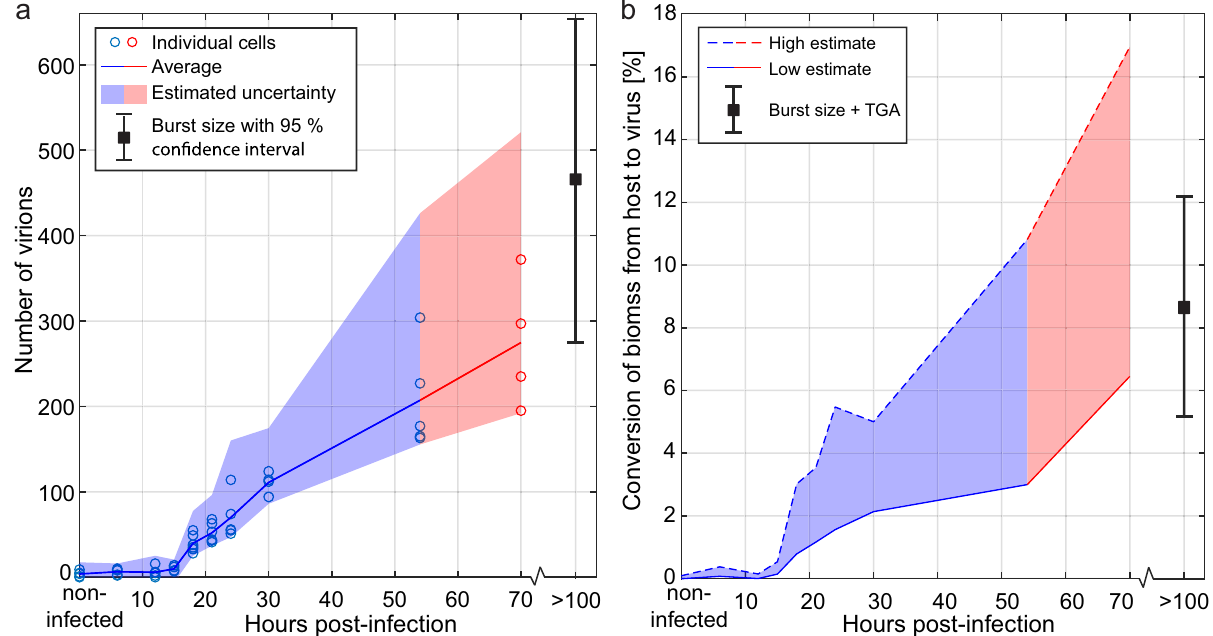
Figure 5. Virion production and conversion of biomass (C 1.3 + N 1.9 + O 0.1 ) as function of infection time. ( a ) The number of virions were counted in 52 different cells with infection times ranging from non-infected (0 h) to 70 h. The data at 70 hpi should be seen as a more approximate count and is therefore displayed in red. Each blue or red ring corresponds to an individual amoeba, while the solid line shows the average at each infection time. An estimated uncertainty (“Materials and methods”) was calculated for each data point and is indicated by the shadowed area. In addition, the result of end-point dilution titrations (n = 15) is shown at > 100 hpi (black square), including a 95% confidence interval. ( b ) The conversion of biomass from host to virus is estimated by measuring the X-ray absorption in the virions compared to the whole cell, in 32 X-ray images with sufficient quality. A high estimate (dashed line) is calculated by summing the absorption in the areas in the images marked as virions. A more moderate estimate (solid line) is given by multiplying the average number of counted virions by the typical absorption in a single virion. The conversion given by the end-point dilution titrations, together with TGA, is shown at > 100 hpi. Note that end-point dilution titrations and TGA were performed at 32 °C in PPYG medium containing 20 mM glucose, whereas quantitative analysis of X-ray micrographs were performed at room temperature in PPYG medium containing no